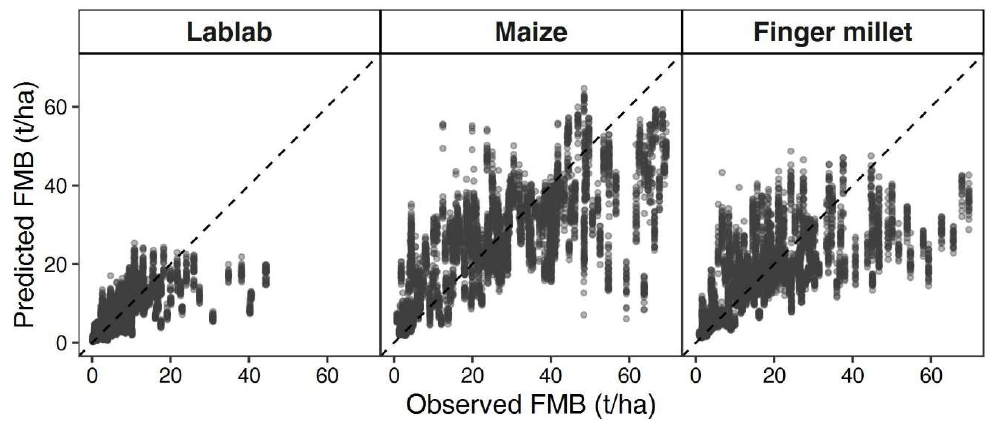
Figure 6. Plot of fit of the Generalised models for fresh matter biomass (FMB) of lablab, maize and finger millet. Each plot shows predictions from 100 RFR models with randomly selected calibration and validation data. Models were built on data from three different years, three levels of N and two levels of water supply (i.e., rainfed and irrigated).